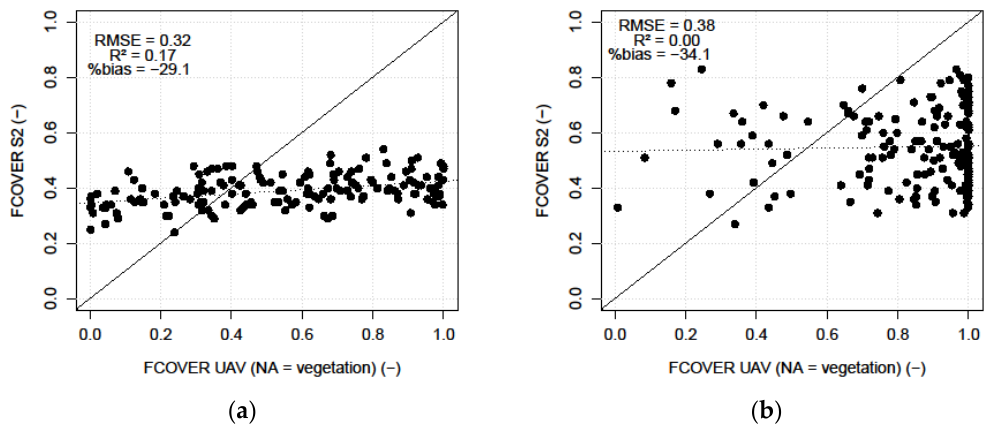
Figure 7. FCOVER-UAV (assumption NA = vegetation) plotted (black dots) against FCOVER-S2 at the ( a ) spring acquisition and ( b ) summer acquisition dates.